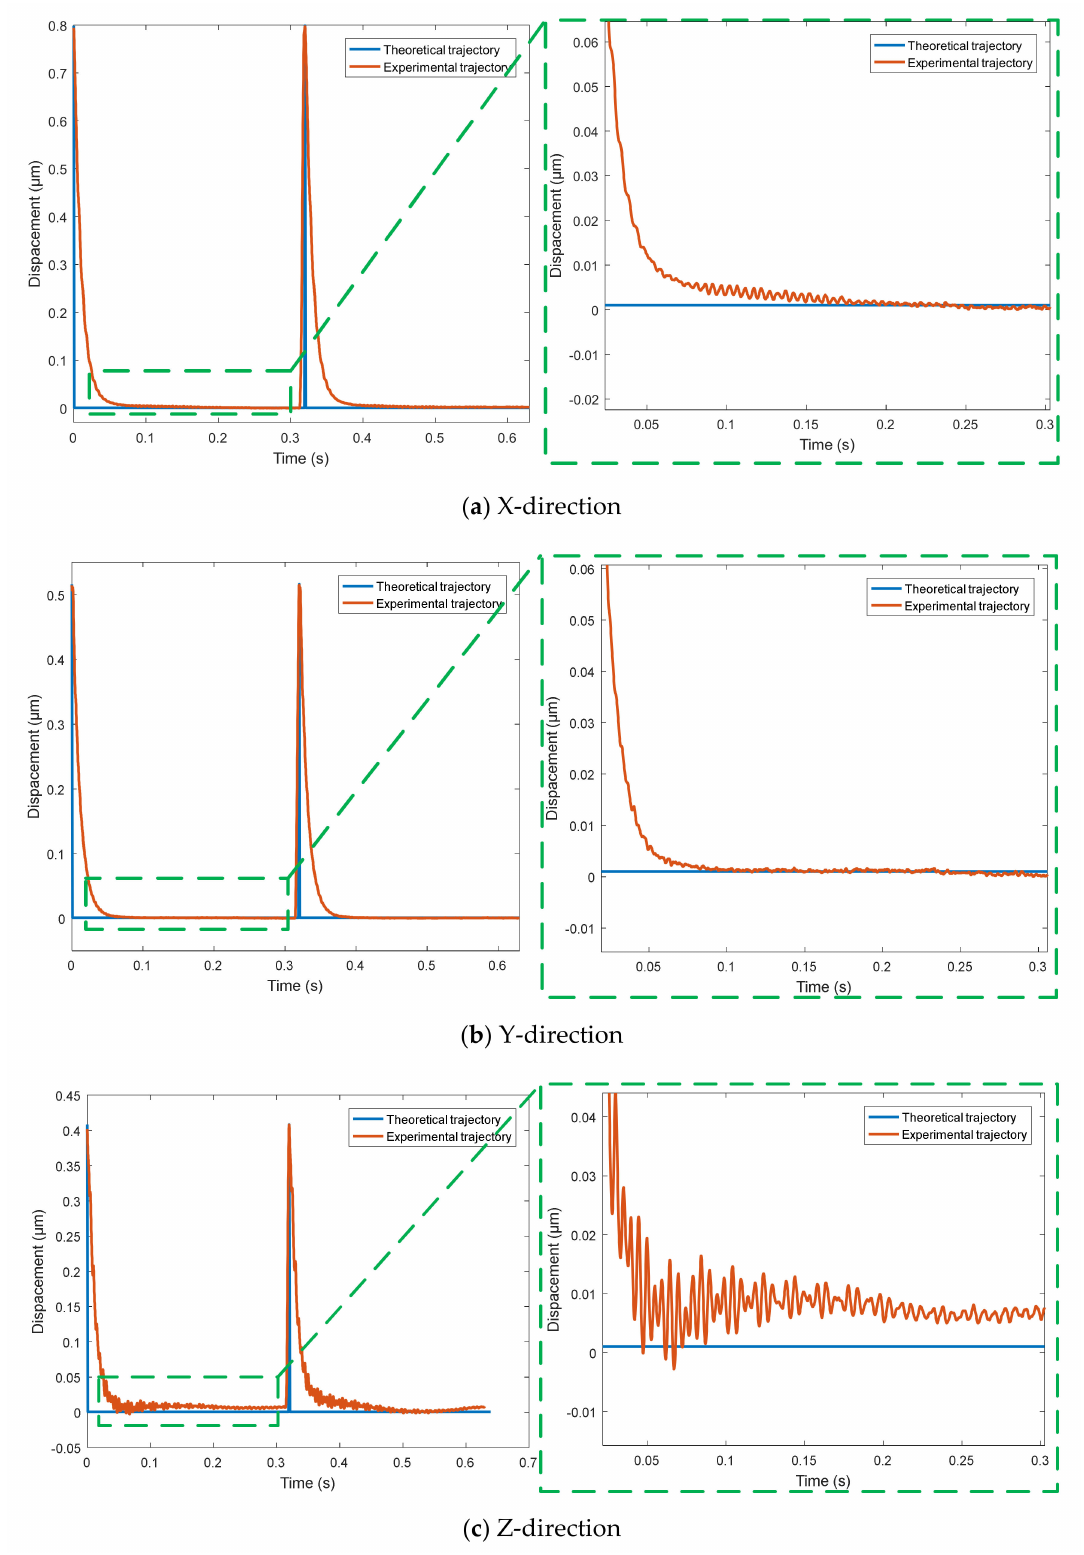
Figure 12. Trajectory tracking performance of step